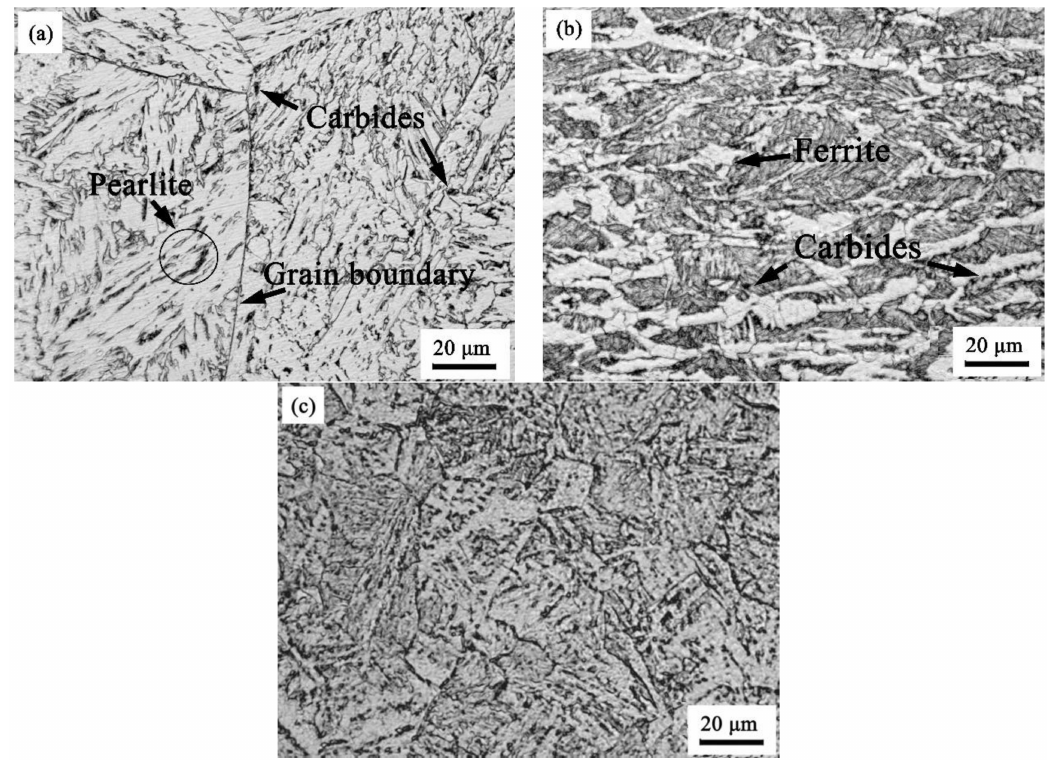
Figure 4. CGHAZ micrographs of ( a ) sample #1 (Bainite + pearlite), ( b ) sample #2 (Bainite + ferrite), and ( c ) sample #3